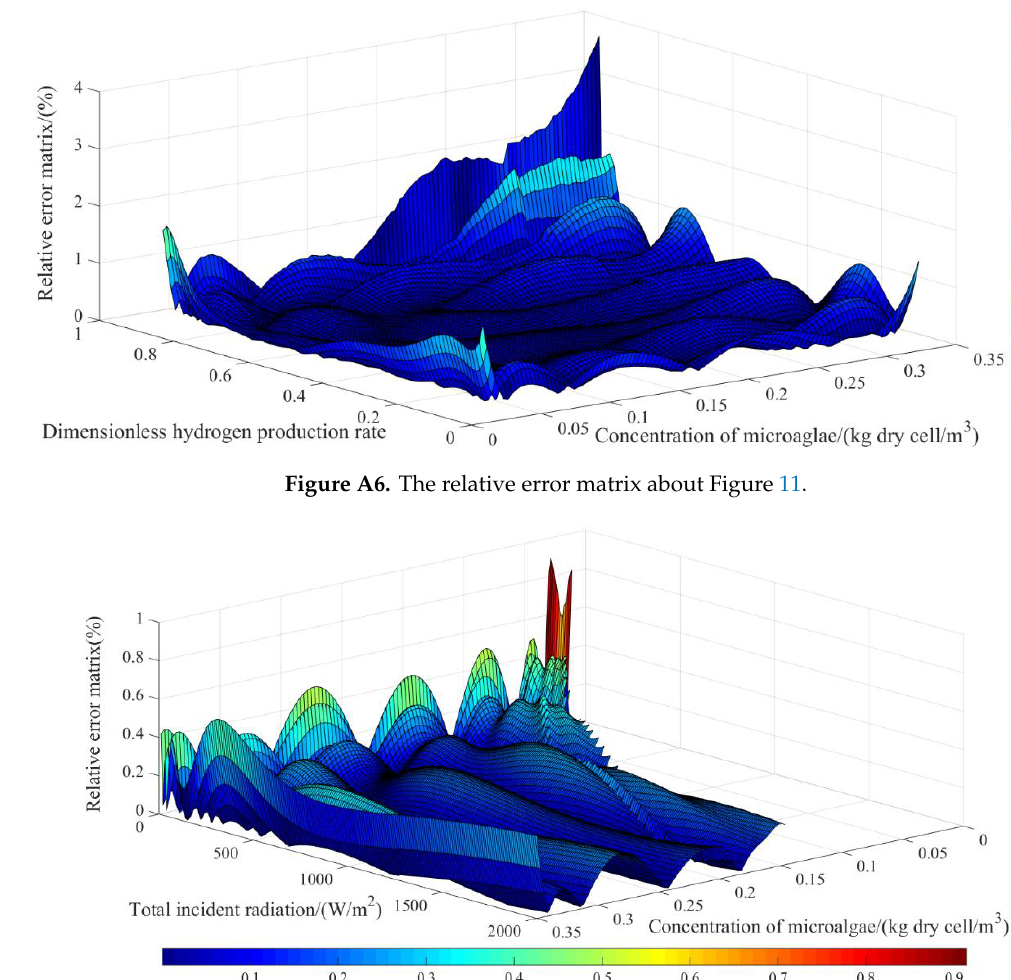
Figure A5. The relative error matrix about Figure 9a.